Question: What does this figure show? Answer in one sentence.
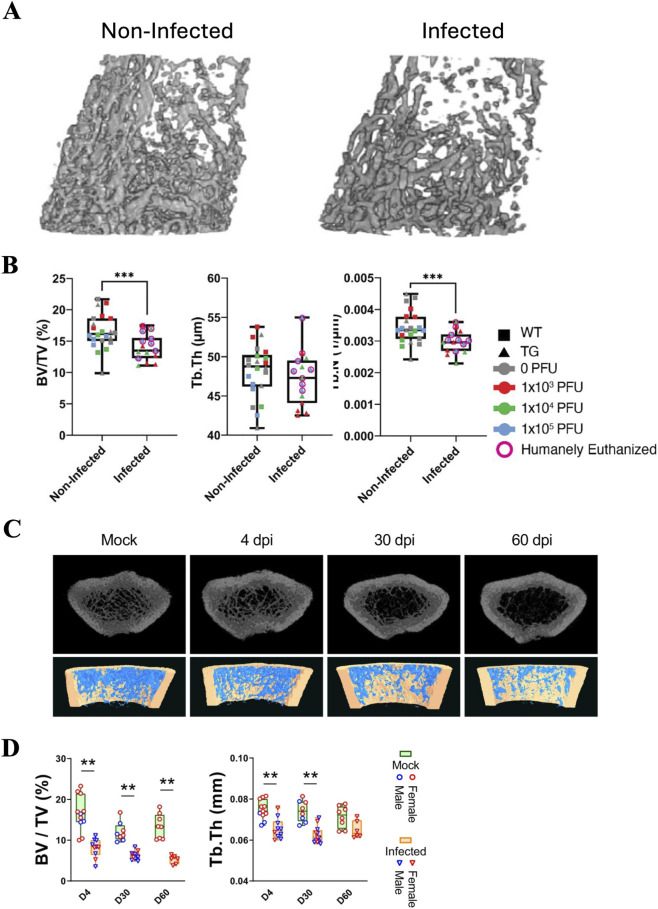
Answer: Effects of SARS-CoV-2 infection on femoral trabecular bone parameters in animal models (A) Representative 3D reconstructed micro-CT images show reduced trabecular density in femurs of SARS-CoV-2-infected mice compared to non-infected controls. (B) Quantitative analysis reveals significant decreases in bone volume fraction (BV/TV), trabecular thickness (Tb.Th), and trabecular number (Tb.N) following infection. ( Awosanya et al., 2021 ). (C) Time-course micro-CT imaging at 4-, 30-, and 60-day post-infection (dpi) illustrates progressive deterioration of trabecular structure. (D) Bone morphometric data demonstrate sustained loss in BV/TV and Tb.Th in both male and female golden Syrian hamster model over time, indicating a long-lasting impact of SARS-CoV-2 infection on skeletal microarchitecture ( Qiao et al., 2022 ).